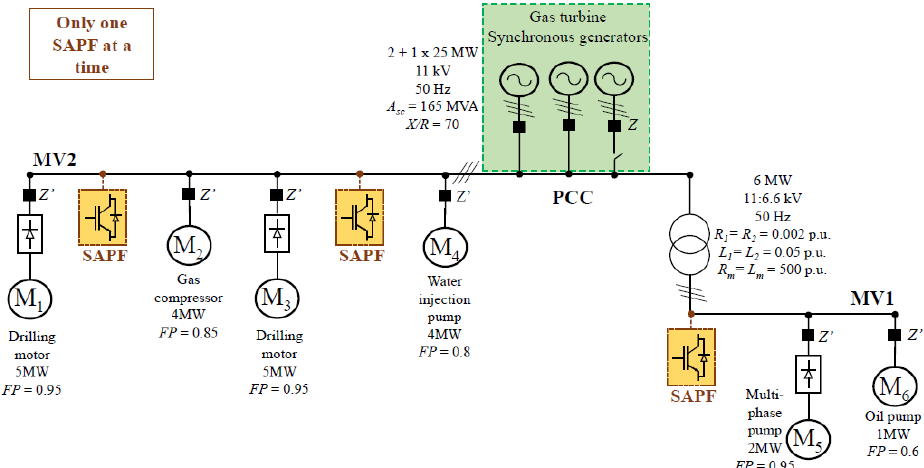
Figure 2. Diagram of a typical power grid of an offshore oil and gas platform (SAPF—Shunt Active Power Filters) [15].